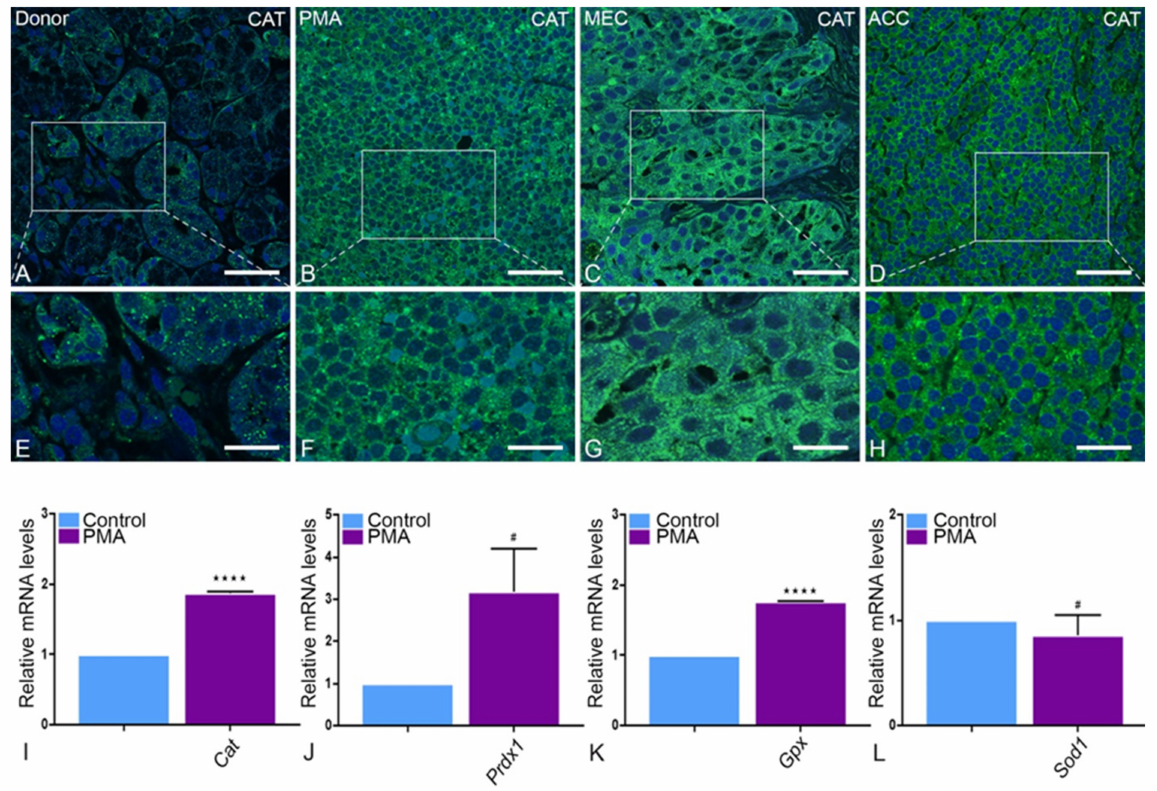
Figure 6. Expression of catalase in PMA, MEC and ACC: In the control parotid gland tissue and its magnification ( A , E ), CAT is expressed significantly lower than in PMA ( B , F ), MEC ( C , G ) and ACC ( D , H ). This result is validated by mRNA expression of Cat in the control parotid gland tissue and PMA (**** p < 0.0001) ( I ) as determined by real-time PCR analysis. The mRNA levels of Prdx1 ( J ) and Gpx (**** p < 0.0001) ( K ) are higher in PMA than in the control group as well. Compared with the control, only the real-time PCR mRNA levels of Sod1 ( L ) are expressed lower in PMA. Bars represent 50 µ m: ( A – D ); 18 µ m: ( E – H ). (Explanation of the notations: The number of asterices signifies the degree of significance of the p -value, while # means not